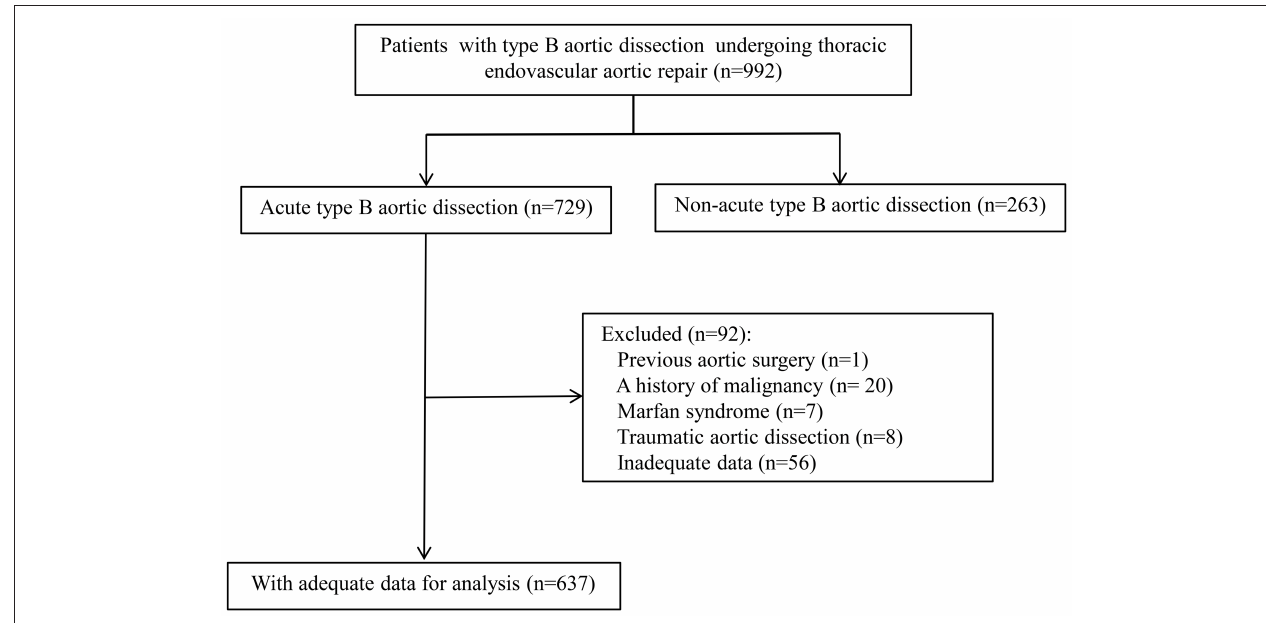
FIGURE 1 | Flow diagram of the included population of acute type B aortic dissection patients treated with thoracic endovascular aortic